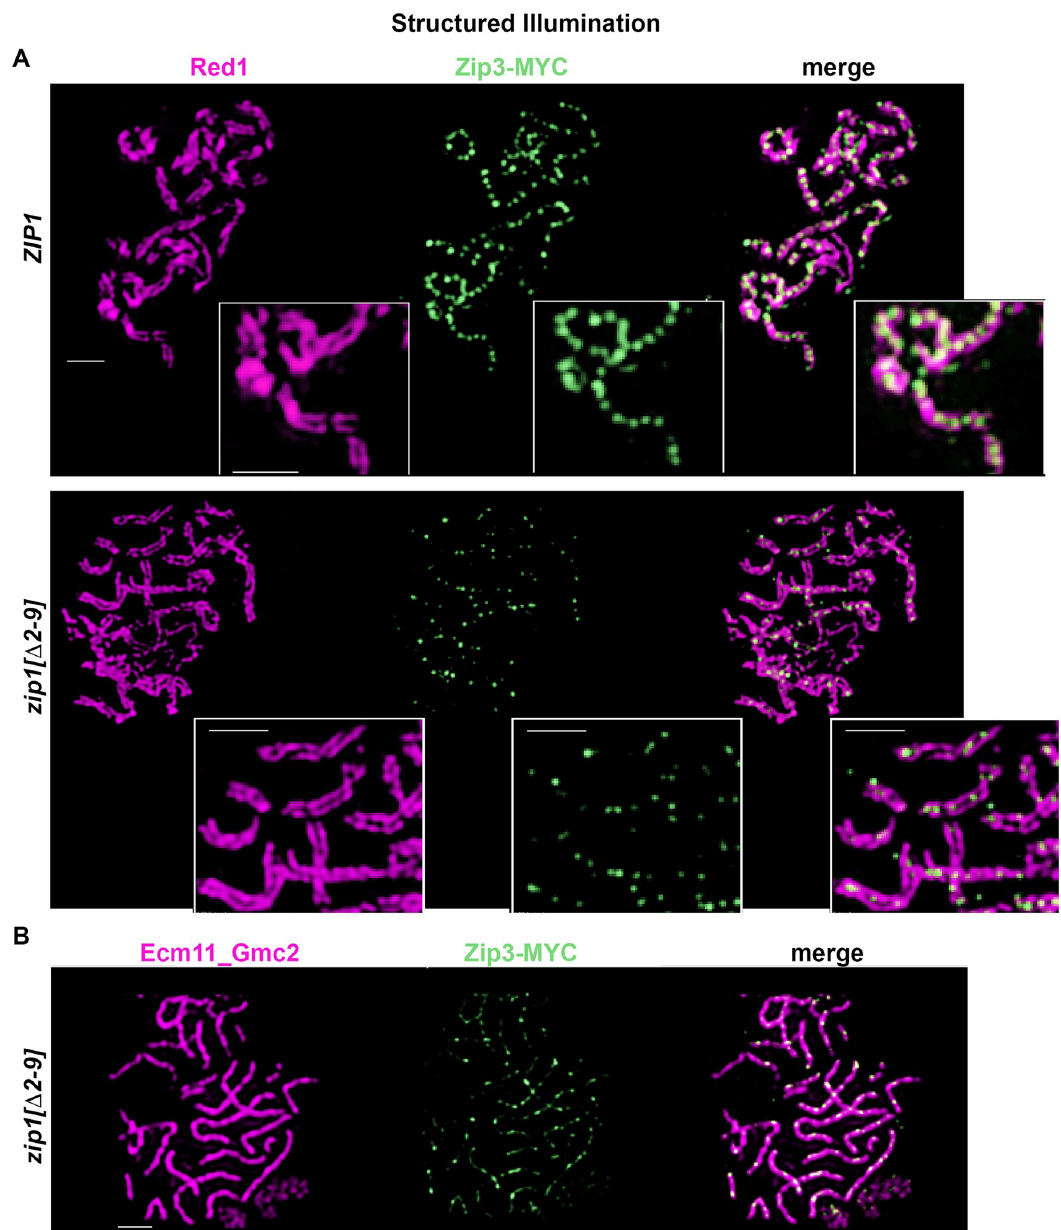
Fig 12. Zip3-MYC foci localize to the SC central element sub-structure in wild-type meiotic nuclei and are diminished in number and intensity in zip1[ Δ 2–9] and zip1[ Δ 10–14] strains. Images show representative surface-spread meiotic nuclei labeled with antibodies against the chromosomal axis protein Red1 (magenta) and antibodies against the MYC epitope to label Zip3-MYC (green). ( A ) In wild-type strains (AM4171), structured illumination microscopy reveals Zip3-MYC foci directly in between lengthwise-aligned homologous chromosome axes in mid-meiotic prophase nuclei, reflecting the embedded distribution of Zip3 complexes within the central region of SCs. ( B ) The position of Zip3-MYC foci in between lengthwise-aligned axes is unchanged but the number of robust Zip3-MYC foci is severely diminished in zip1[ Δ 2–9] strains (AM4277). Zip3-MYC’s location within the central element substructure of the SC in this strain is also indicated in this image, where Zip3-MYC (green) is co-labeled with antibodies that target Ecm11-Gmc2 (magenta). Scale bar, 1 μ